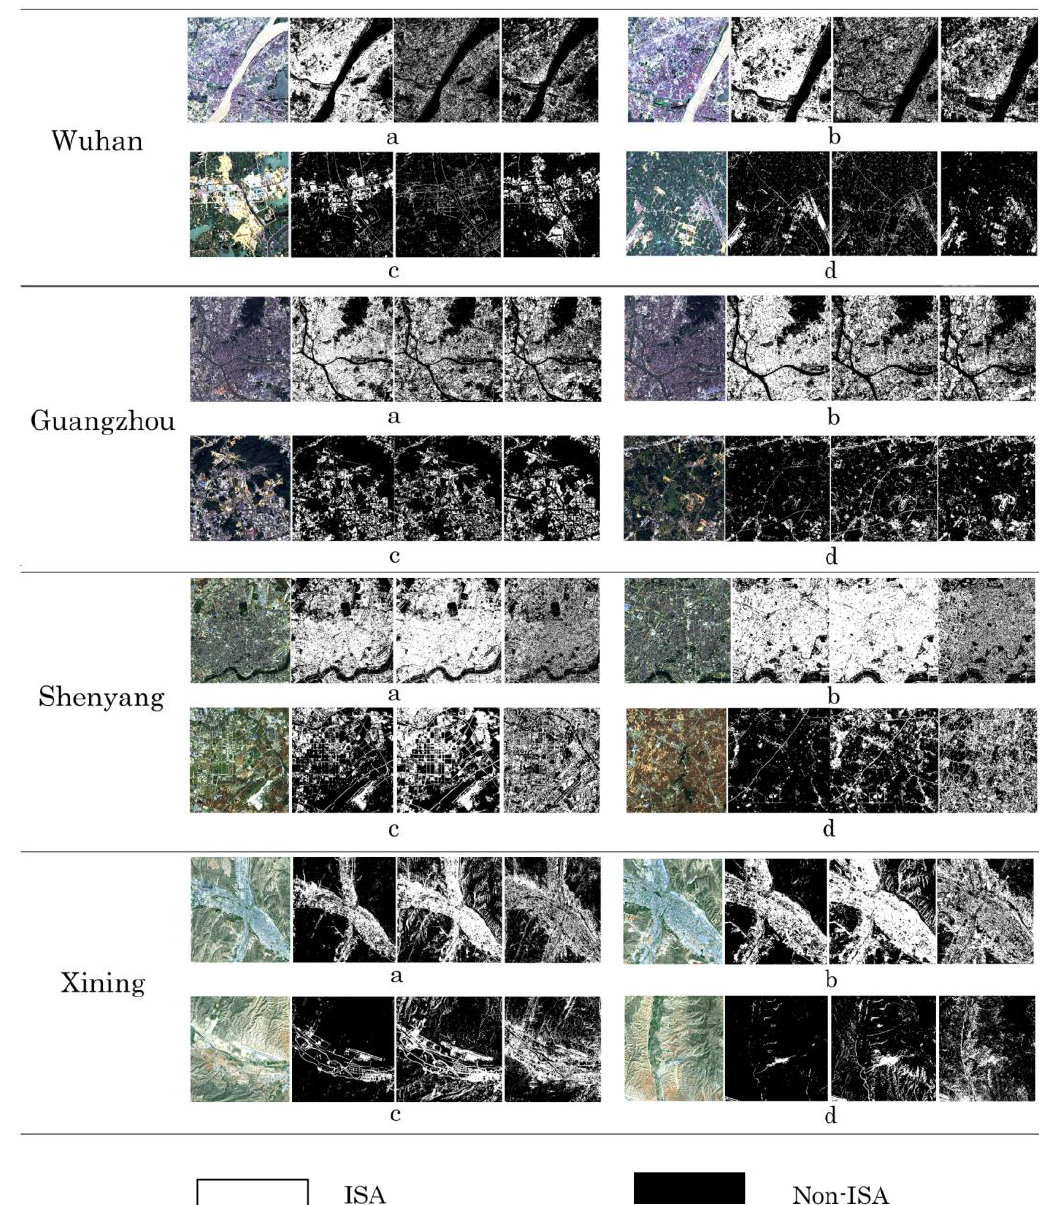
Figure 15. ISA extraction results for each city: ( a – d ) the overall, urban, suburban, and rural scene extraction results, respectively. In each unit, from left to right, are true-color composite images and the results of ISA extraction using PISI, BCI, and NDBI.